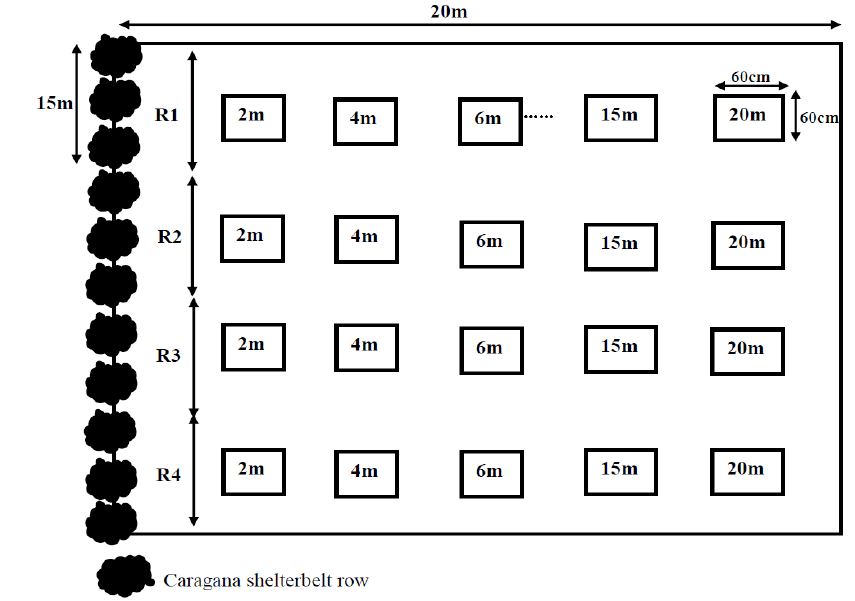
Figure 1. Diagram (not drawn to scale) of experimental plot layout showing replicates and sampling subplots at 2 m, 4 m, 6 m, 15 m and 20 m from the caragana shelterbelt (60 cm × 60 cm) within each 15 m